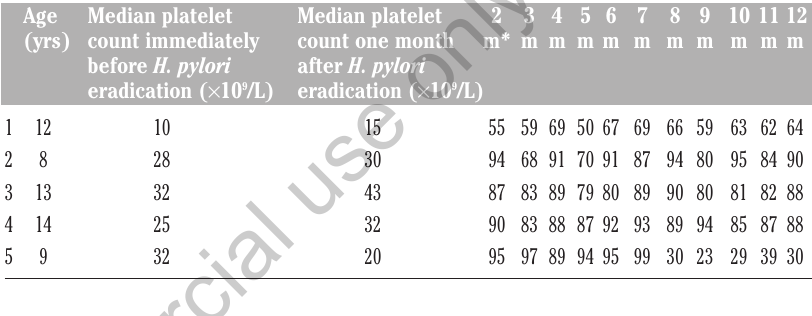
Table 2. Monthly platelet count during 12 months after eradication of H. pylori in patients with chronic